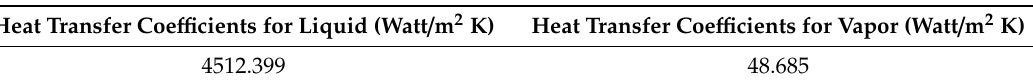
Table 4. Heat transfer coe ffi cients (Watt / m 2 K) used in Aspen PLUS at conditions of an experiment of 30 ◦ C, flow rates 53 mL / min, and at a bed height of 0.5 m.